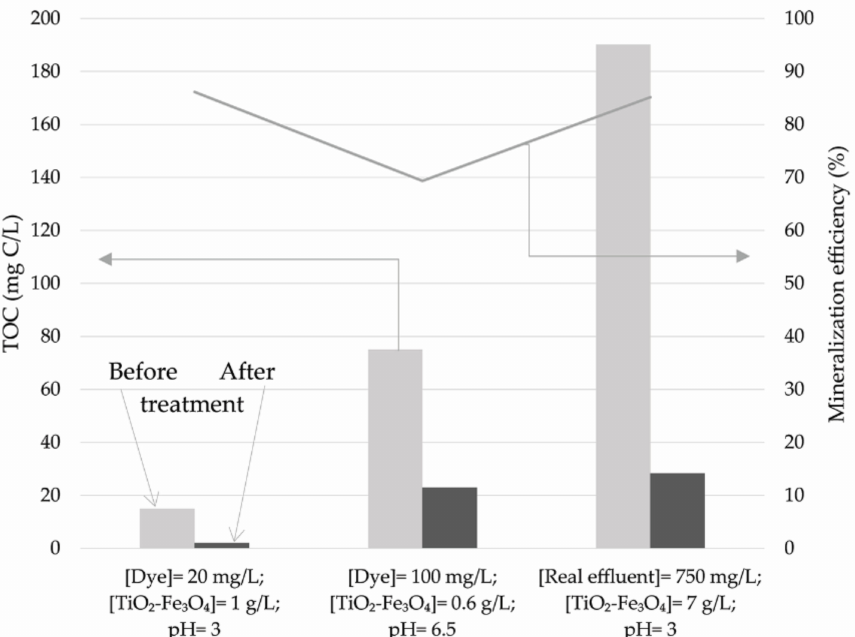
Figure 9. TOC concentrations and mineralisation efficiencies for synthetic dye solution (maximal efficiency and optimal conditions) and real effluent (maximal efficiency conditions).